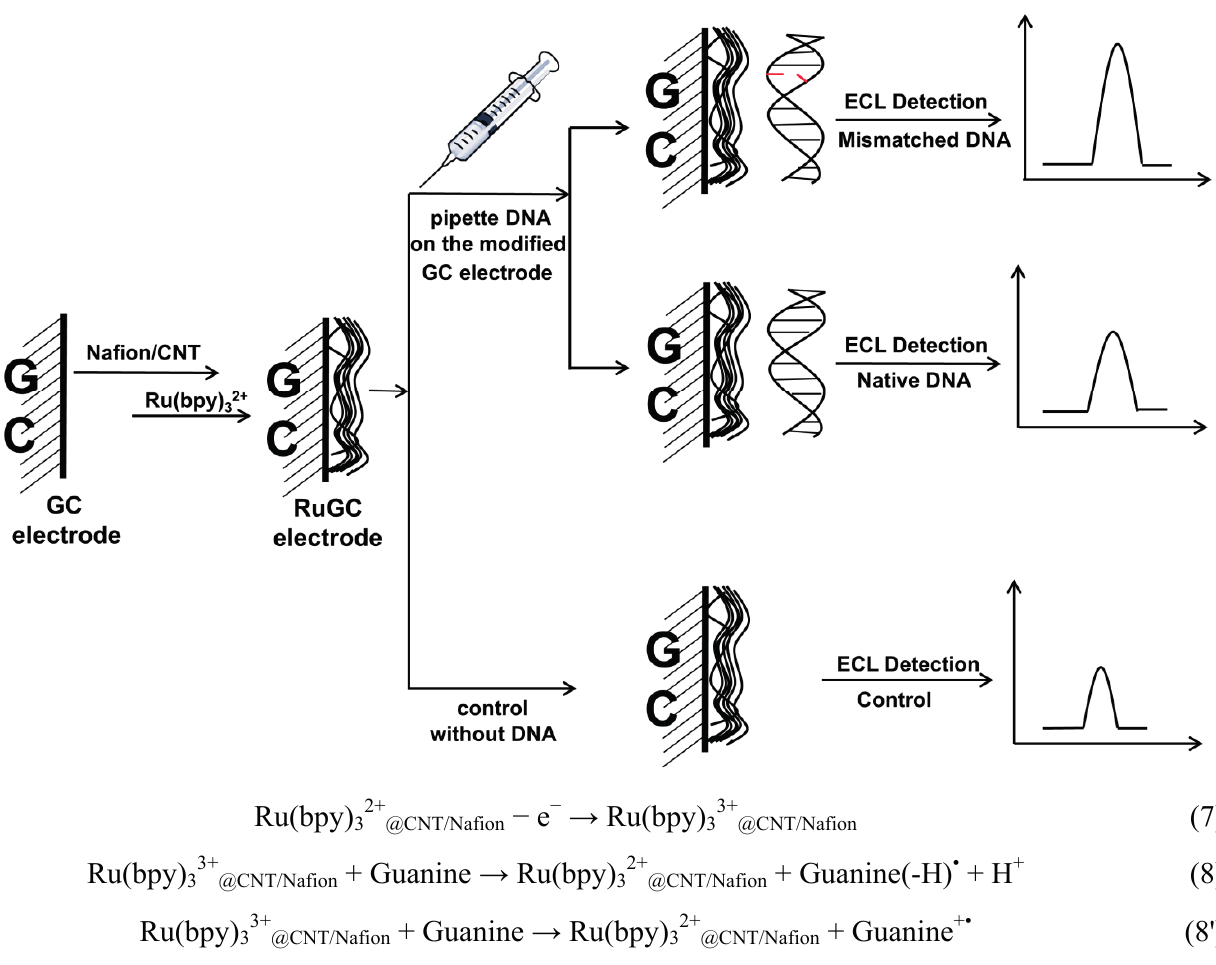
Figure 6. Schematic of ECL DNA detection using a Ru(bpy) 32+ modified GC electrode. GC, glassy carbon; CNT, carbon nanotubes. Adapted with permission from ref. [75], copyright (2007)